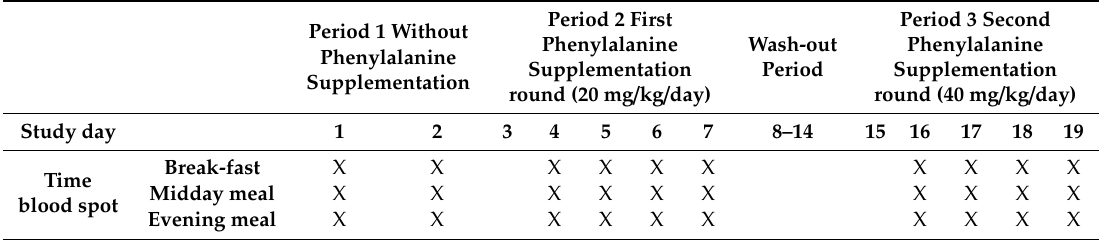
Table 1. Overview of the di ff erent study periods with sample